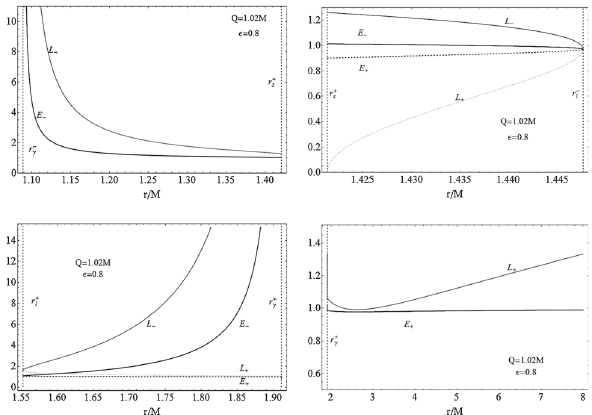
√ Fig. 9 Class : M < Q ≤ 5 /( 2 6 ) M and (cid:9) (cid:2) + < (cid:2) ≤ (cid:2) l . Parameter choice is as follows: Q = 1 . 02 M and (cid:2) = 0 . 8. Then (cid:2) l = 0 . 806548, (cid:9) (cid:2) + = 0 . 697649, r + = 1 . 42131 M , r − = 1 . 08866 M , r + = 1 . 91134 M , γ γ s = 1 . 44769 M , and r + = 1 . 55231 M . Circular orbits exist with r − l l angular momentum L = L + ( gray curves ) and energy E = E + ( black curves ) in r − γ < r < r + s ( upper left plot ); L = L ± in r + s ≤ r < r − l ≤ r < r + = L − in ( upper right plot ) and r + γ ( bottom left plot ); L l r ≥ r + γ ( bottom right plot )